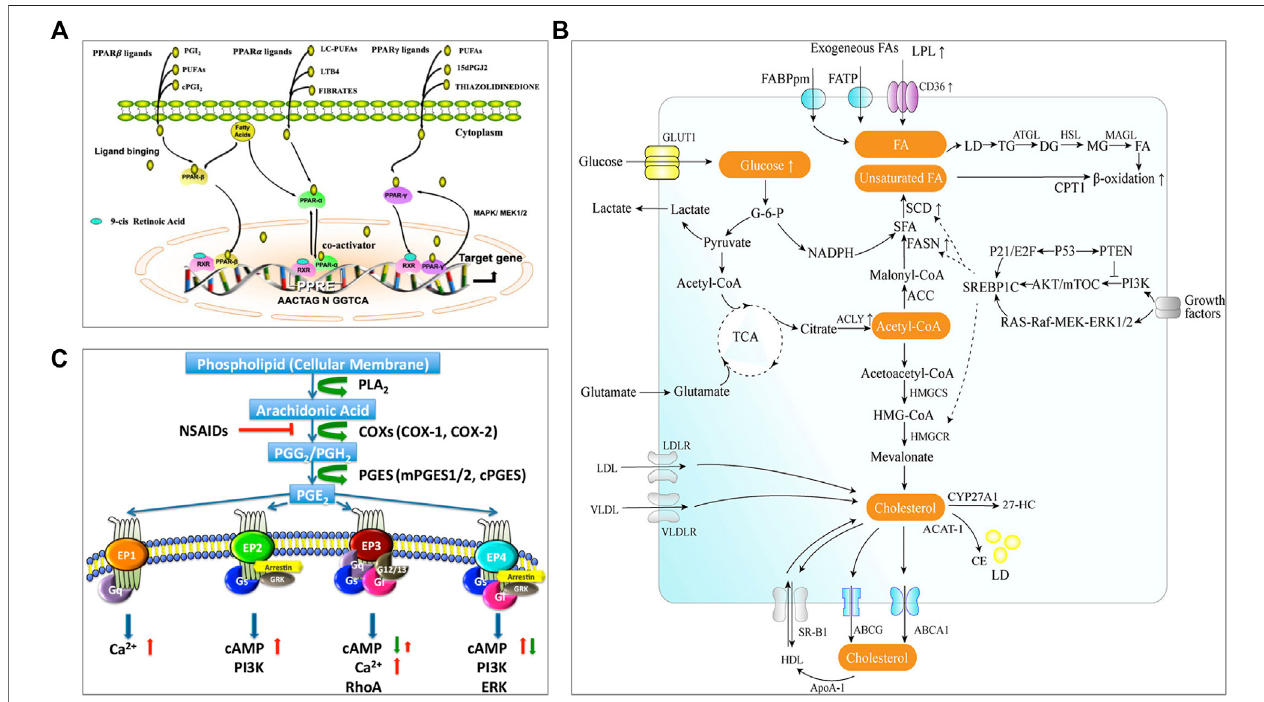
FIGURE 1 | Lipid metabolism and pathways closely related to the occurrence and development of tumors. (A) PPAR signaling (Peng et al., 2021). The complete transcriptional activity of PPAR requires the binding of homologous lipid ligands. Endogenous PPAR ligands are originated from the nuclear membrane or transferred from the cytoplasm. PPAR can shuttle between the nucleus and cytoplasm, and it is mainly located in the nucleus. Ligand binding promotes PPAR conformational changes, enabling PPAR to interact with another nuclear receptor (retinoic acid IDX receptor, RXR) to form heterodimerization. The combination of PPAR heterodimer with PPAR response element (PPRE) in the target gene promoter activates the expression of related genes. (B) The metabolism pathway of fatty acid and cholesterol (Wang et al., 2020). There are two sources of intracellular fatty acids: intake of exogenous fatty acids and de novo synthesis of fatty acids. Exogenous fatty acids can be absorbed by cells through speci fi c transporters, e.g., CD36, FATP, and FABPpm. Endogenous fatty acid synthesis begins with the product of acetyl-CoA from thetricarboxylicacidcycle (TCA) anddependson theactivity offatty acidsynthase(FAS). Theintracellular fatty acidsarestoredinlipid droplets (LD).Fatty acidswill be catalyzed through mitochondria β -oxidation to produce energy. Intracellular cholesterol homeostasis mainly includes the regulation of de novo synthesis, uptake, storage, and ef fl ux. Cells can absorb exogenous cholesterol through receptors, e.g., LDLR and VLDL. Endogenous cholesterol is synthesized by the mevalonate pathway. Excessive cholesterol in the cells will be transported outside through transporters, e.g., ABCA1, ABCG1, or converted into cholesterol esters by ACAT1 catalysisandstoredinaformoflipiddroplets.Cholesterolcanbeconvertedintocholesterolderivativesundertheactionofrelatedenzymese.g.,CYP27A1tosupportlife activities. (C) Arachidonic acid and PGE2 signaling (Li et al., 2017). Arachidonic acid (AA) is a polyunsaturated fatty acid that forms the phospholipid domain of cell membranesandcouldbereleased fromthecellmembrane bycytoplasmicphospholipaseA2(PLA2).FreeAAismetabolized toPGG2andPGH2 bycyclooxygenase-1 (COX-1) or COX-2. PGH2 isrelatively unstable and successively metabolized to PGE2 by cPGES and mPGES1/2. PGE2could bind tofour GPCRs (EP1-EP4). Different receptors are coupled to different signaling pathways. Reprinted under the Creative Commons CC BY